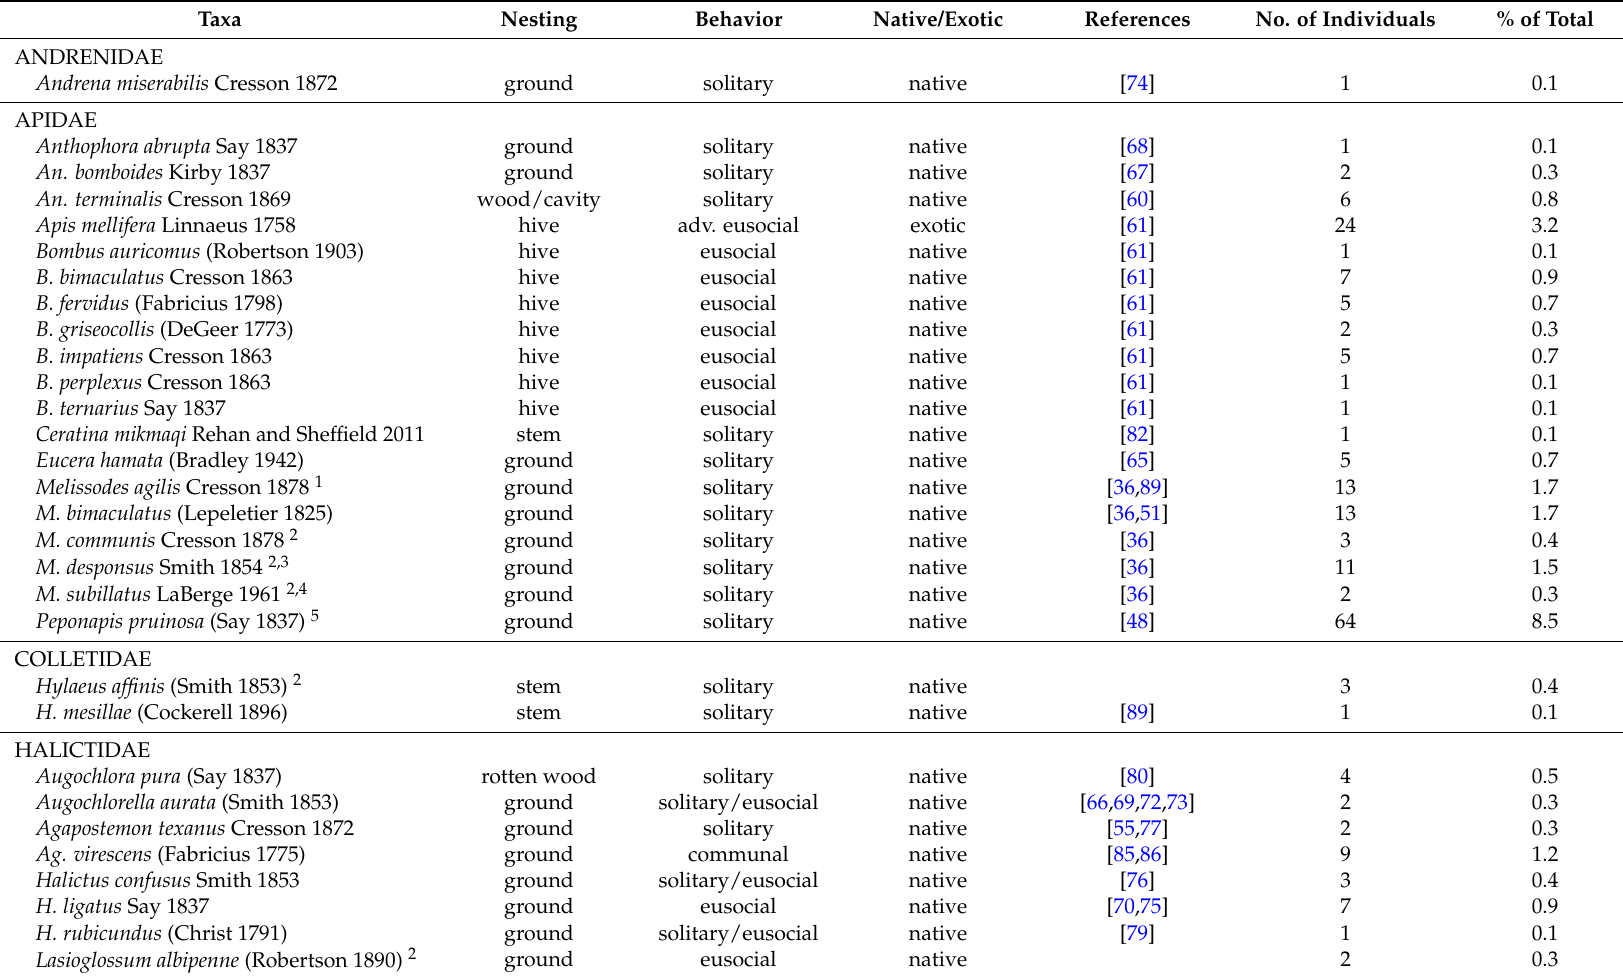
Table 2. Species names and characteristics of bees captured in bowl and blue vane traps in 12 commercial potato fields in Michigan in 2016. Biological data are based on published studies and reviews